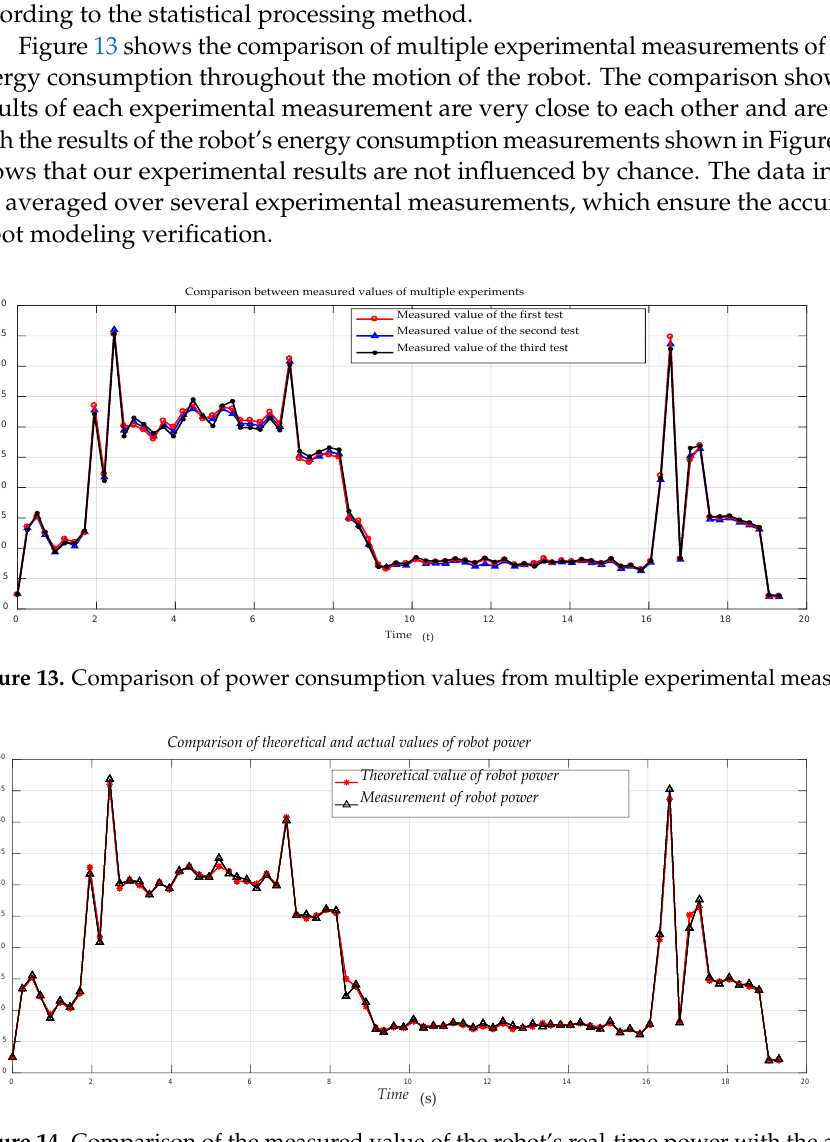
Figure 14. Comparison of the measured value of the robot’s real-time power with the actual value during the movement.